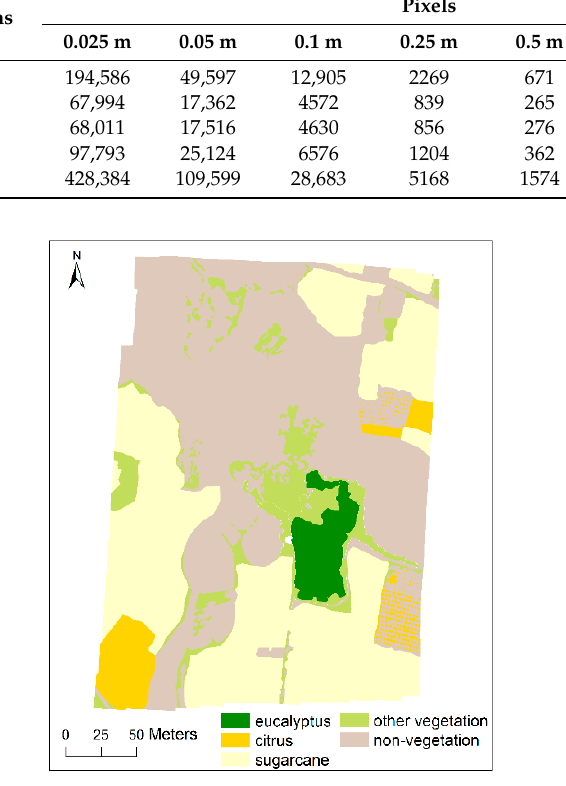
Figure 2. Ground truth reference image.